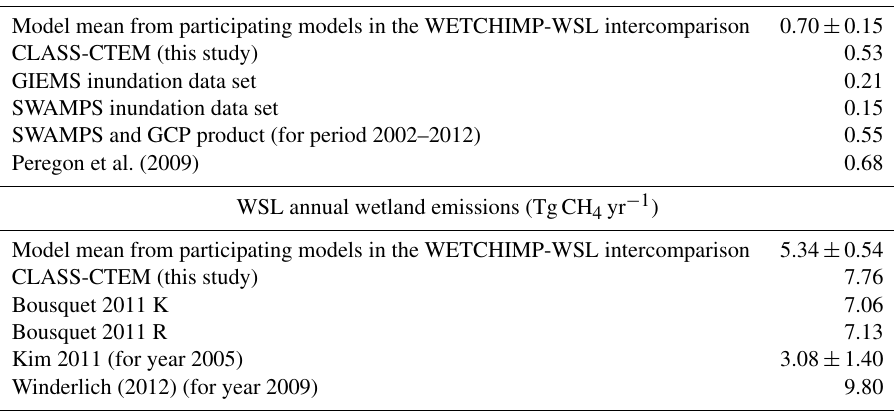
Table 2. Comparison of CLASS-CTEM simulated annual methane emissions and annual maximum wetland extent for the West Siberia lowlands (WSL) region with models participating in the WETCHIMP-WSL intercomparison and observation- and inversion-based estimates as discussed in Sect. 3.5. Numbers shown are mean ± standard error from Bohn et al. (2015) for models participating in the WETCHIMP- WSL intercomparison. Standard error is not available for all inversions. All values are reported as average for the period 1993–2004 unless otherwise